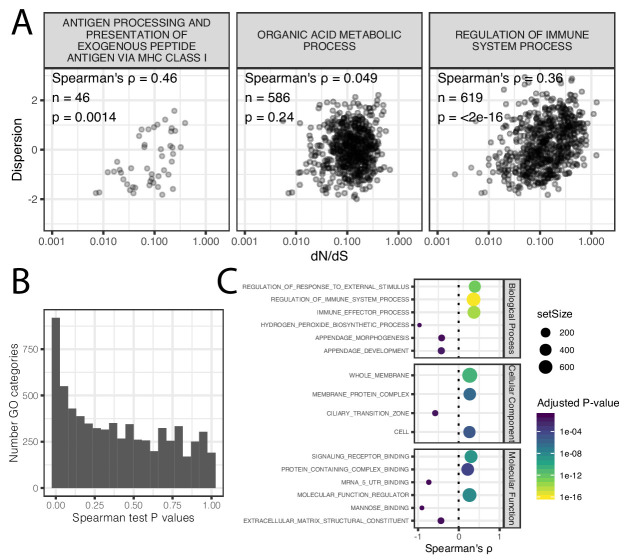
Correlation of coding conservation and dispersion across gene categories.(A) The correlation between dN/dS across mammals and dispersion (human-chimpanzee dispersion estimate mean) when only considering genes in three example GO categories (B) Histogram of distribution of spearman correlation test p-values across GO categories. (C) The most three most significant (Adjusted p-value<0.05) gene categories for each effect direction for each ontology group. Spearman test results for all GO categories available as Figure 3—figure supplement 1—source data 1.Figure 3—figure supplement 1—source data 1.dN/dS correlation with dispersion by GO category.